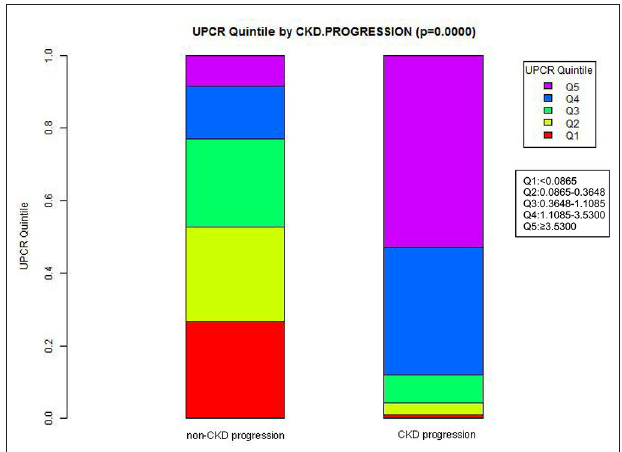
FIGURE 3 | Data visualization of UPCR of all participants from CKD progression and non-CKD progression groups. The results indicated that the distribution level of UPCR in the CKD progression group was higher, while the level of UPCR in the CKD progression-free group was relatively low.